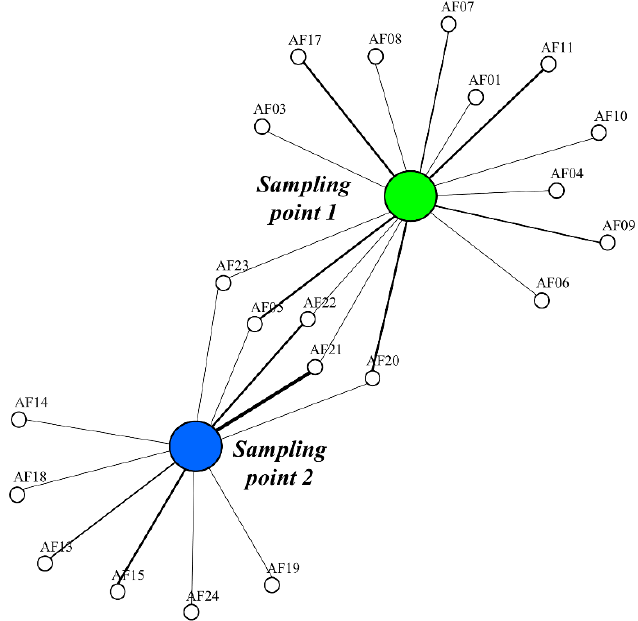
Figure 2. Fungal sharing between Arachnitis uniflora plants sampled in two forest understoreys: sampling point 1 (green) and 2 (blue). Line width relates to the isolation frequency of fungi.